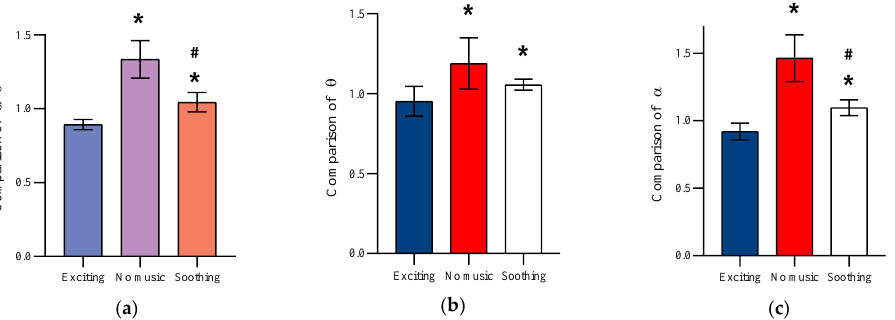
Figure 6. Comparison of the variation of α , θ , and α + θ under different background music modes. ( a ) Comparison of α + θ . ( b ) Comparison of θ . ( c ) Comparison of α . *: Significant difference from exciting Music mode. #: Significant difference from no Music mode.